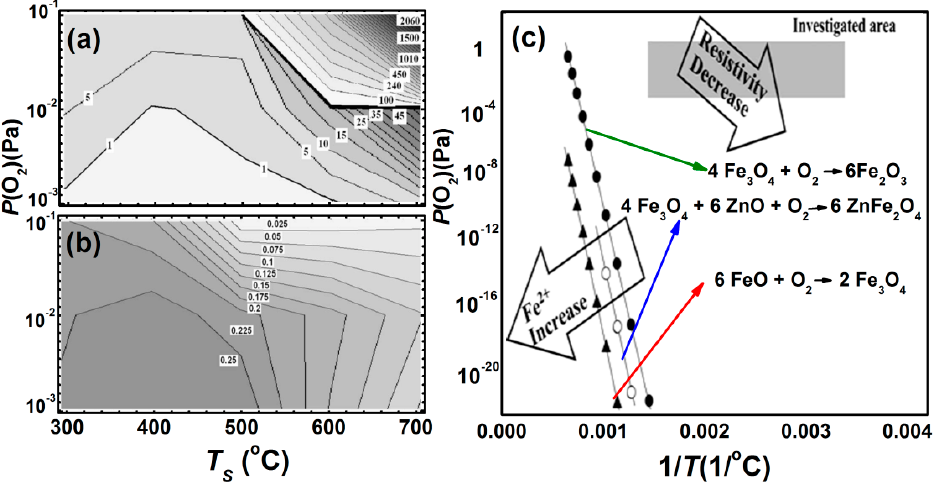
Figure 7. ( a ) Variation of room temperature resistivity ( Ω -cm) and ( b ) saturated magnetization (emu/mm 3 ) of Zn y Fe 3 − y O 4 thin films with oxygen pressure, P (O 2 ) and substrate temperature, T S , respectively. ( c ) Comparison between thermodynamic equilibrium lines (the amount of Fe 2+ ) and resistivity variation trend (Reproduced with permission from [44]. Copyright AIP Publishing, 2007).